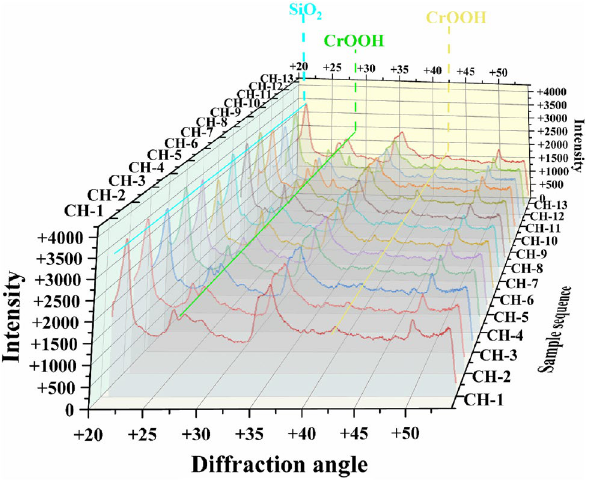
Figure 5. XRD diffractogram of bentonite with adsorbed chromium ions. Different colors of curves correspond to different samples. The wave peaks and troughs correspond to different diffraction angles. The experiments were carried out at the temperature of 293.15–298.15 K and the pressure of one atmosphere.